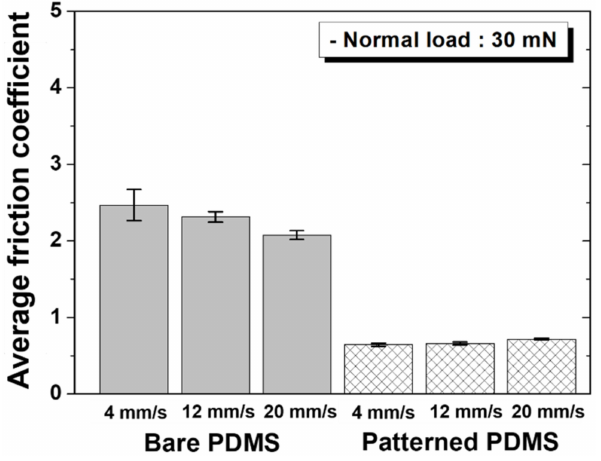
Figure 6. Average friction coefficients as a function of sliding speed under a normal load of 30 mN for bare PDMS and micro/nanopatterned